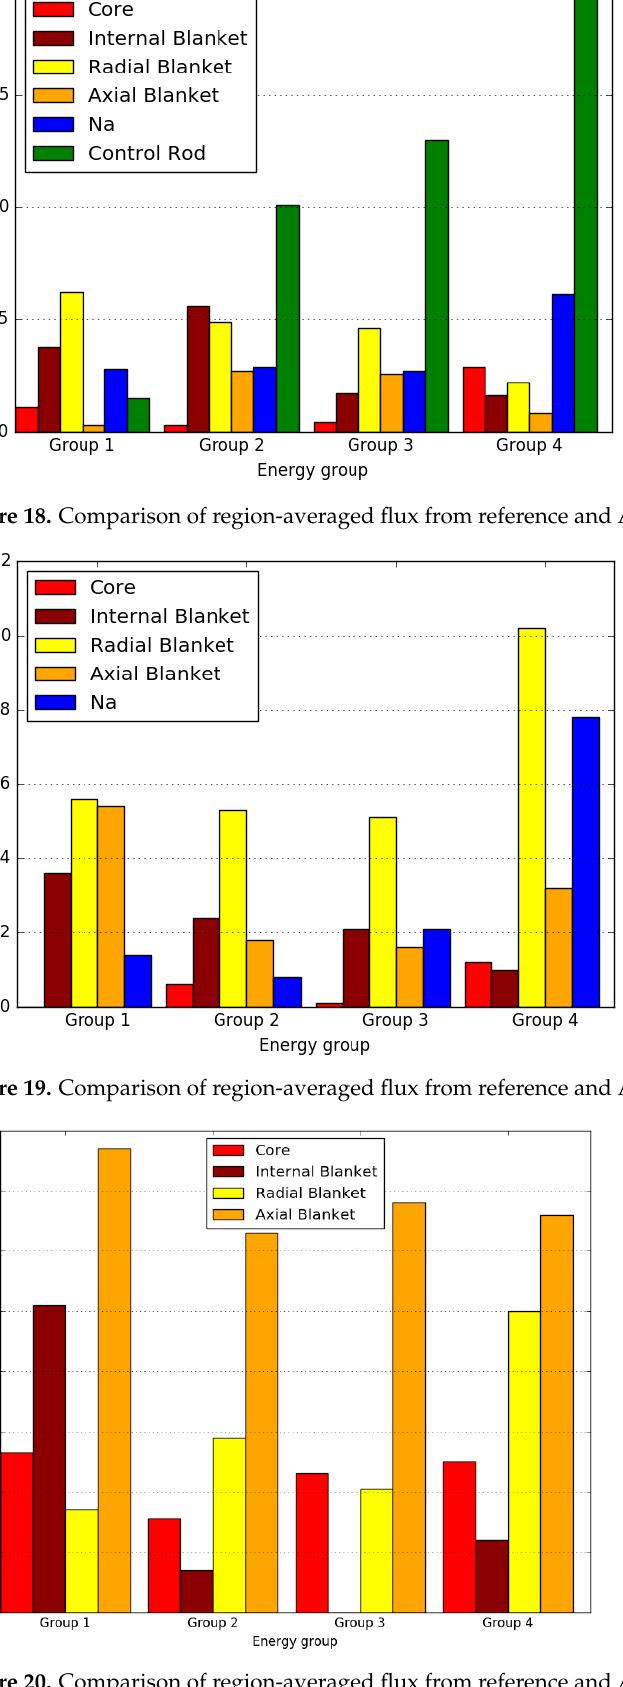
Figure 20. Comparison of region-averaged flux from reference and AZTRAN Model 3 Case